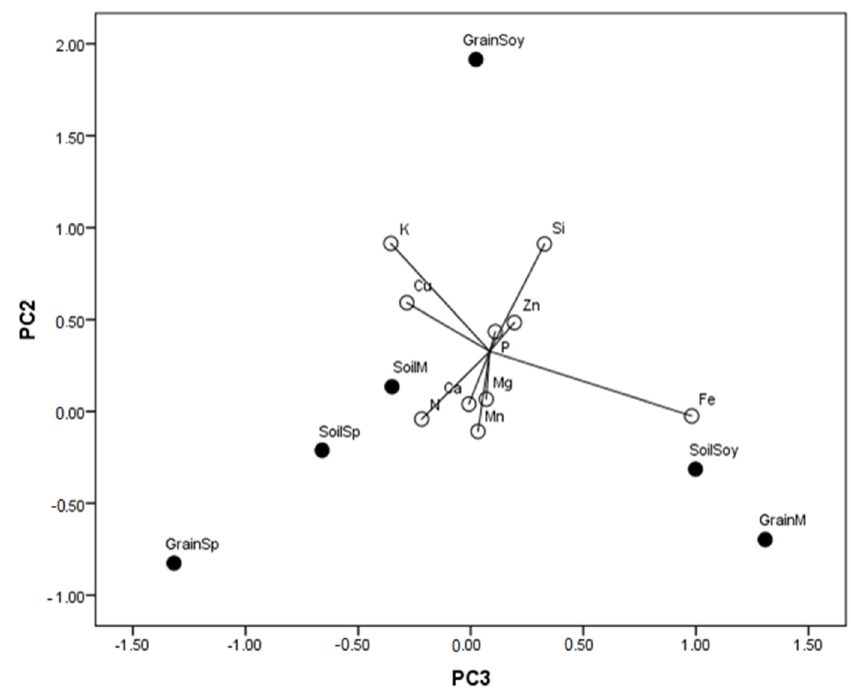
Figure 11. Principal Component Analysis (PCA) for N, P, K, Ca, Mg, Fe, Cu, Mn, Zn and Si concen- tration in soil under spelt (SoilSp), maize (SoilM), and soybean (SoilSoy), as well as the grain of spelt (GrainSp), maize (GrainM), and soybean (GrainSoy).